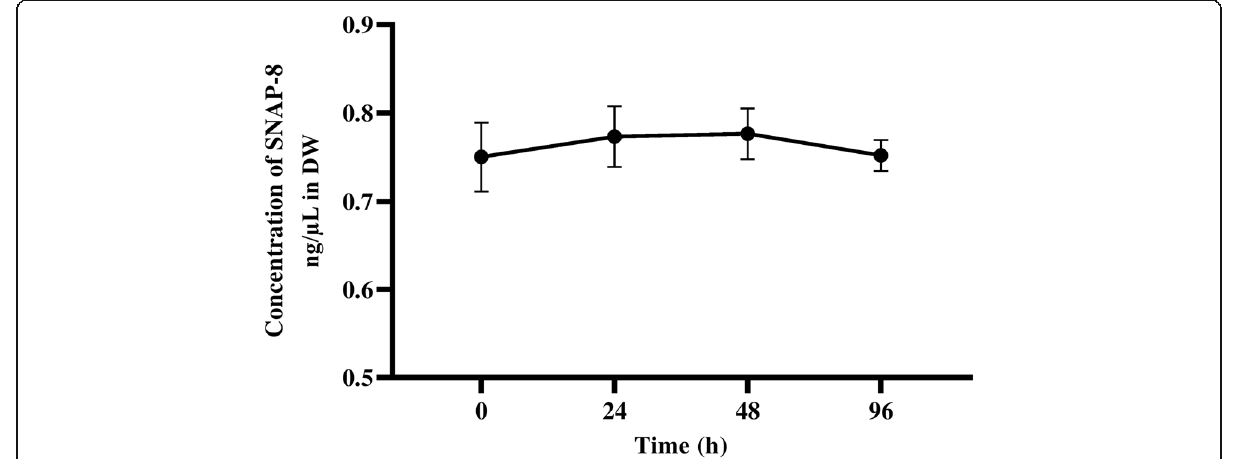
Fig. 5 Stability test of SNAP-8 for 96 h at 4